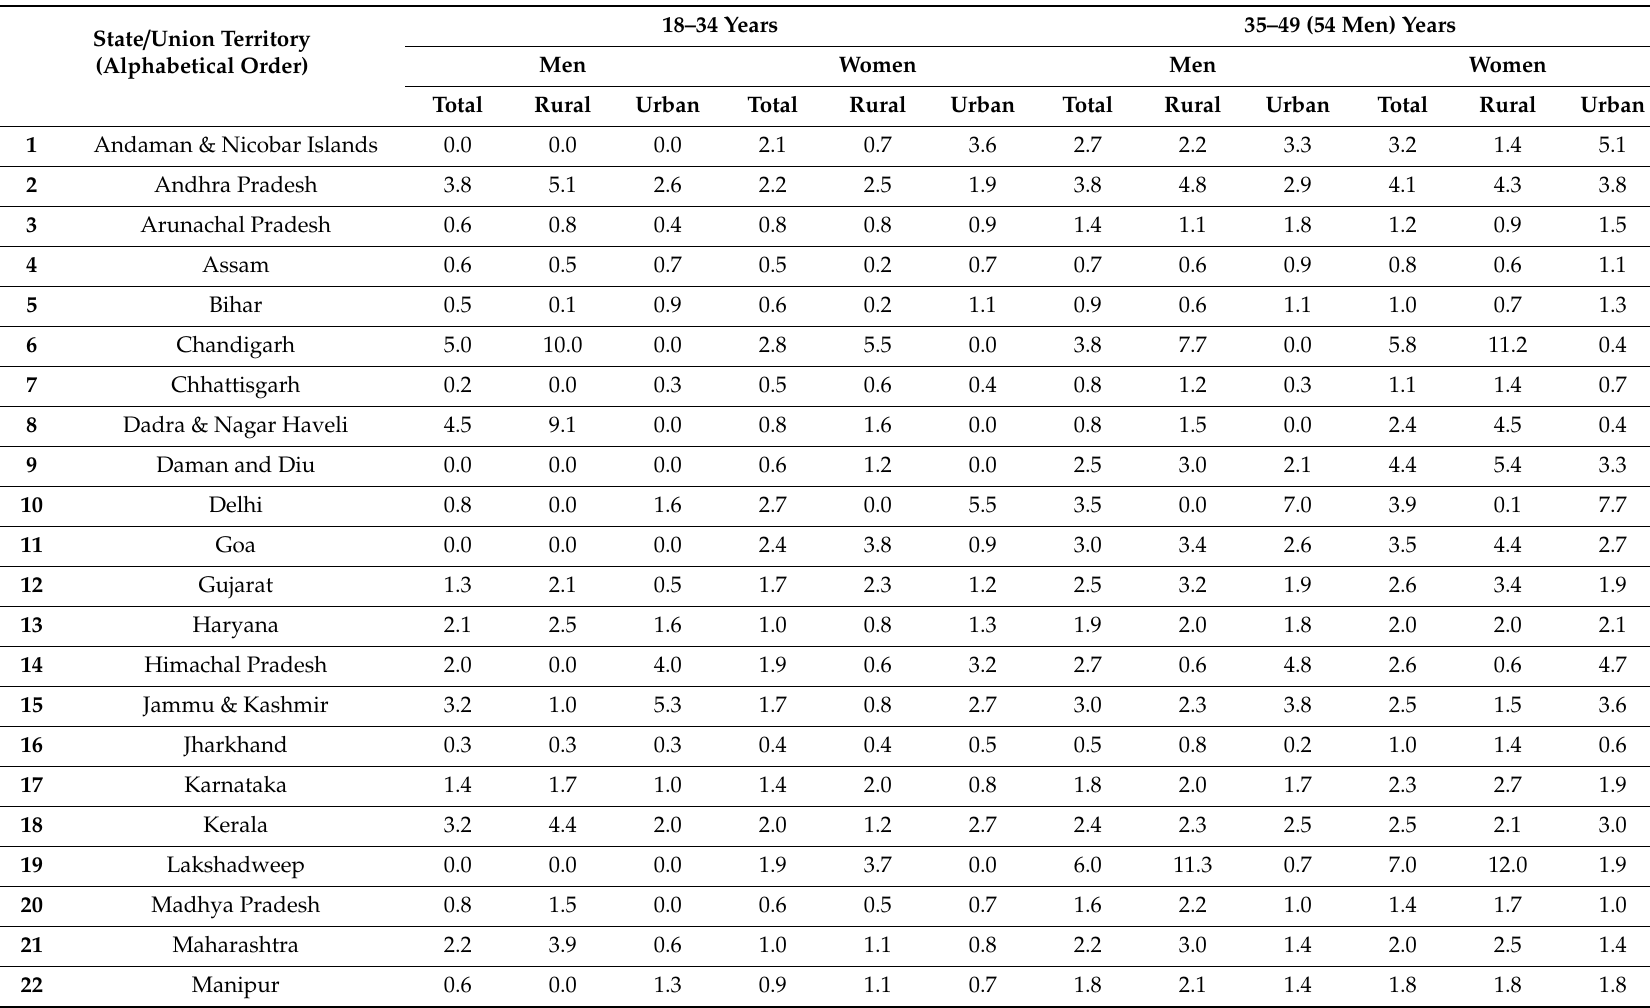
Table 3. The prevalence of obesity among adults according to age group, sex, and type of residence for each state and union